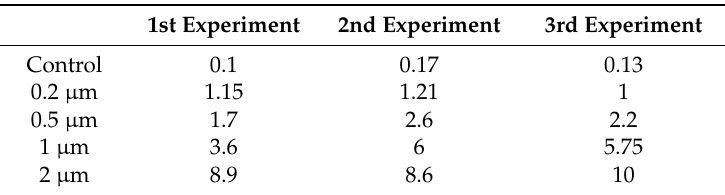
Table 1. Percentage of FL-1 positive cells after 24 h of incubation with green fluorescent beads of different diameters.